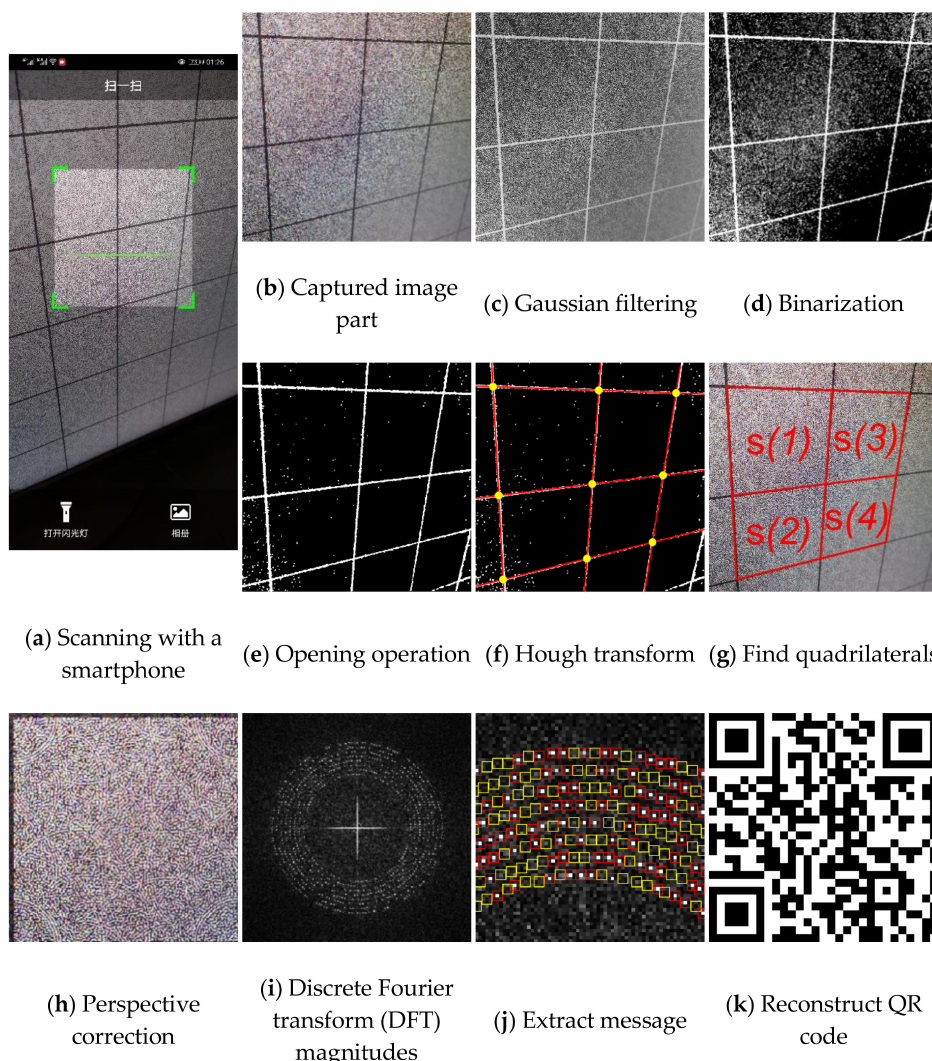
Figure 9. Detection and extraction process of watermark